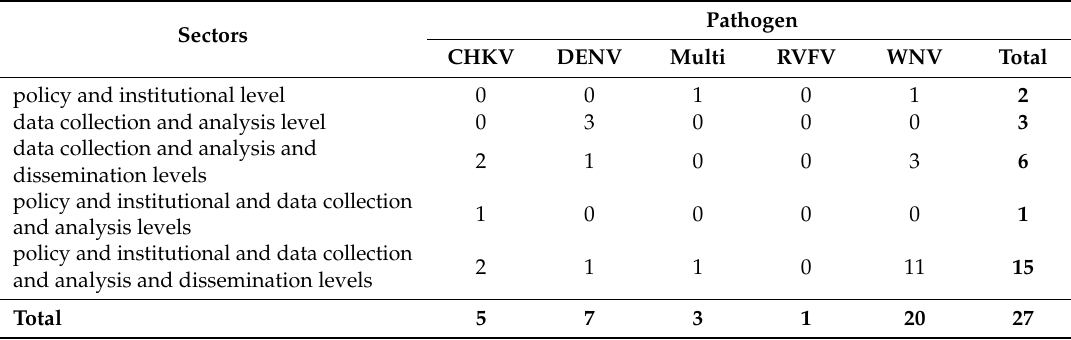
Table 5. Number of articles reporting on the level of surveillance integration, by